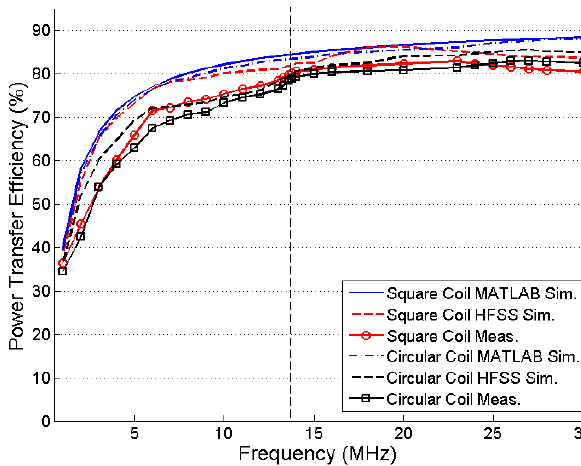
Figure 16. Efficiency versus carrier frequency.